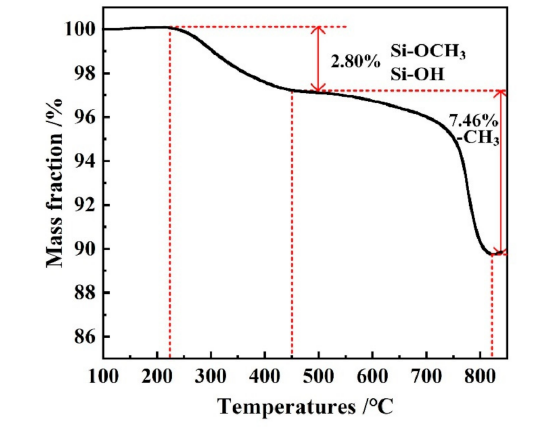
Figure 8. TGA curves of PMSQ microspheres in nitrogen